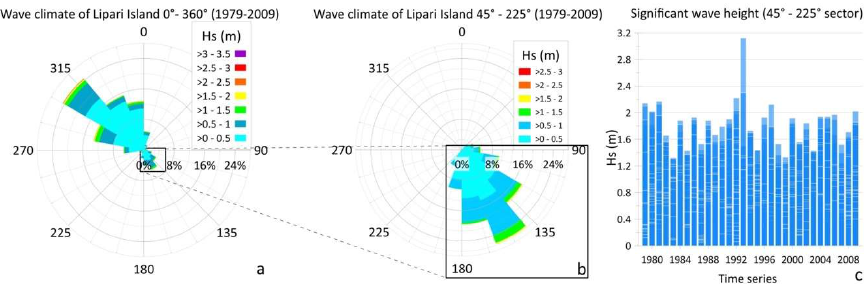
Figure A1. ( a ) Wave climate of Lipari Island (NOAA hindcasting from 1979 to 2009, [35]) represented as the circular histogram of significant wave height (Hs) related to a position to the north-east of Lipari Island (see text for details). The circular histogram in ( b ) represents the analysis of wave data only from the sector 45°–225°N and allows the better appreciation of the characteristics of waves from this provenance sector. ( c ) Time series of significant wave heights from the southeastern sector (45°–225°N).